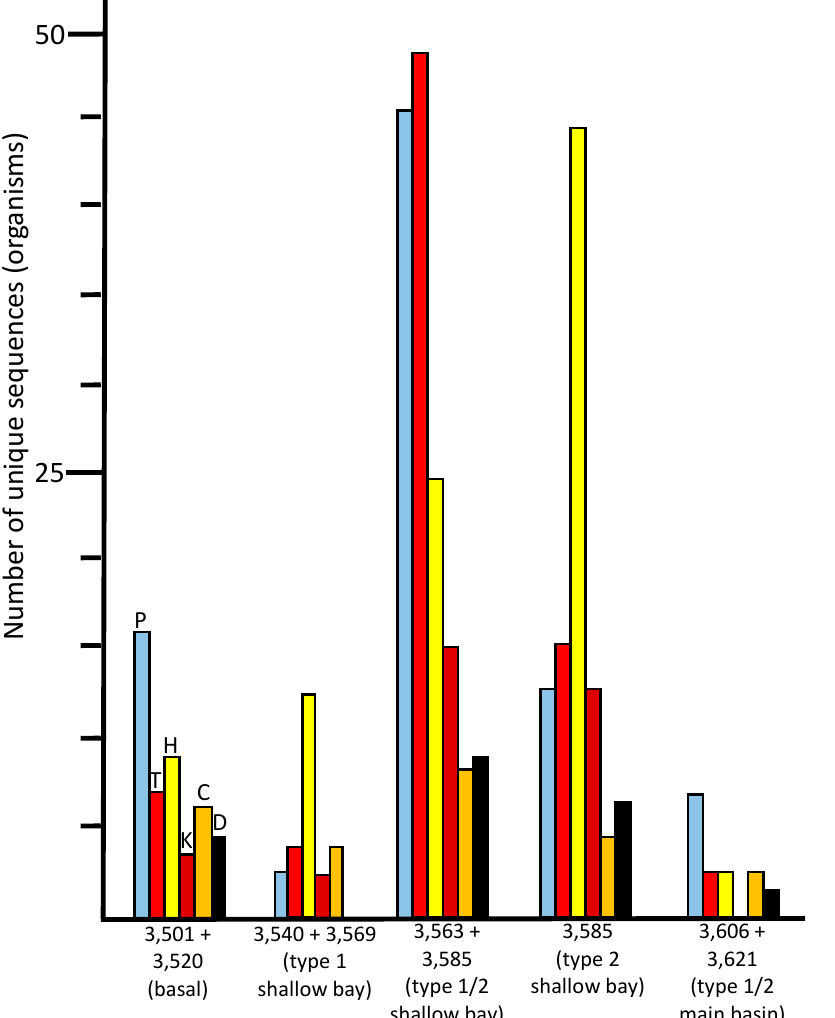
Figure 5. Numbers of unique sequences in the ice core samples that matched sequences from organisms in the NCBI database ( ≥ 97% identity, e-value < 10 − 6 ) that are known to be psychrophilic / psychrotolerant (P, sky blue), thermophilic / thermotolerant (T, red), halophilic / halotolerant (H, yellow), alkaliphilic / alkalitolerant (K, brick red), acidophilic / acidotolerant (C, orange), or desiccation tolerant (D, black).